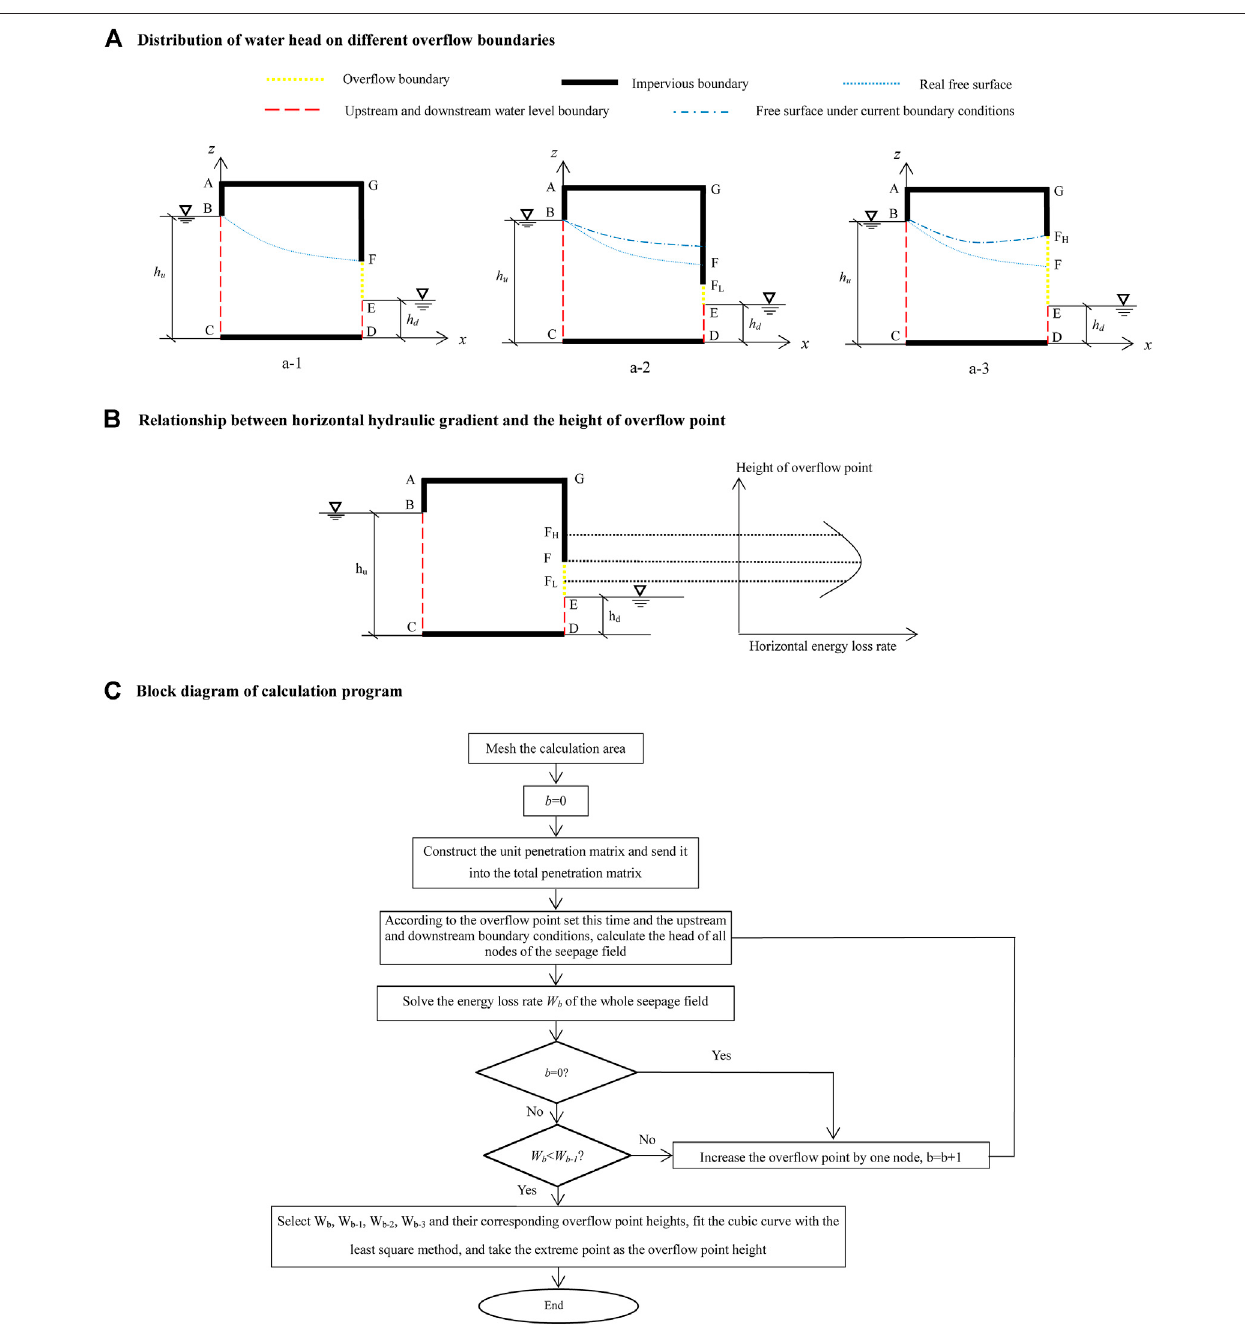
FIGURE 1 | Model information. (A) Distribution of the water head on different over fl ow boundaries. (B) The relationship between horizontal hydraulic gradient and the height of over fl ow point. (C) A block diagram of calculation program.